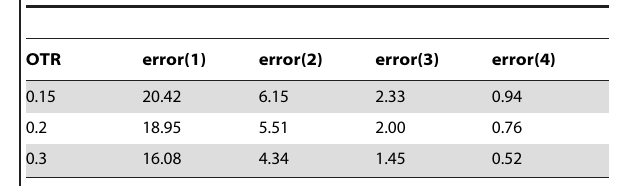
Table 3. Relative errors in percentage for the effective resistance of M-trees.